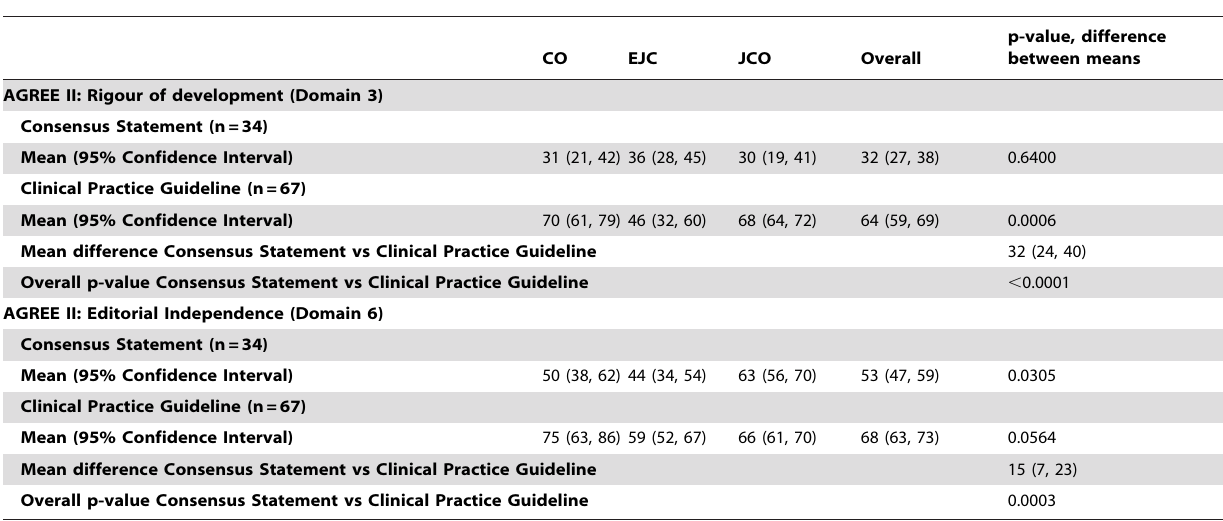
Table 2. AGREE II: Rigour of development and Editorial Independence.